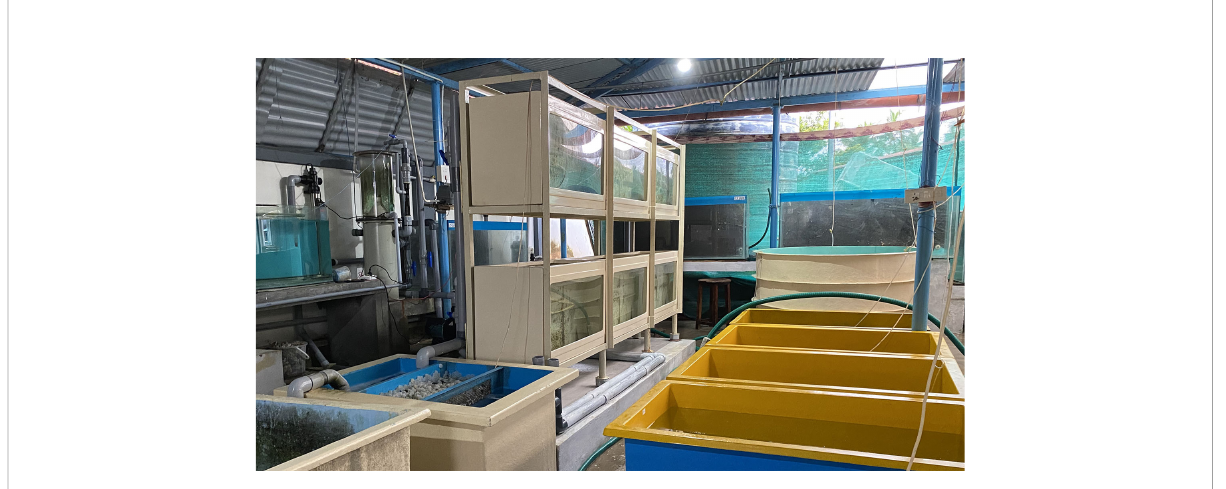
FIGURE 1 Multi-tank RAS unit for clown fi sh rearing and